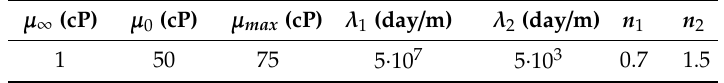
Table 2. Carreau parameters used to create the reference (base case) rheology